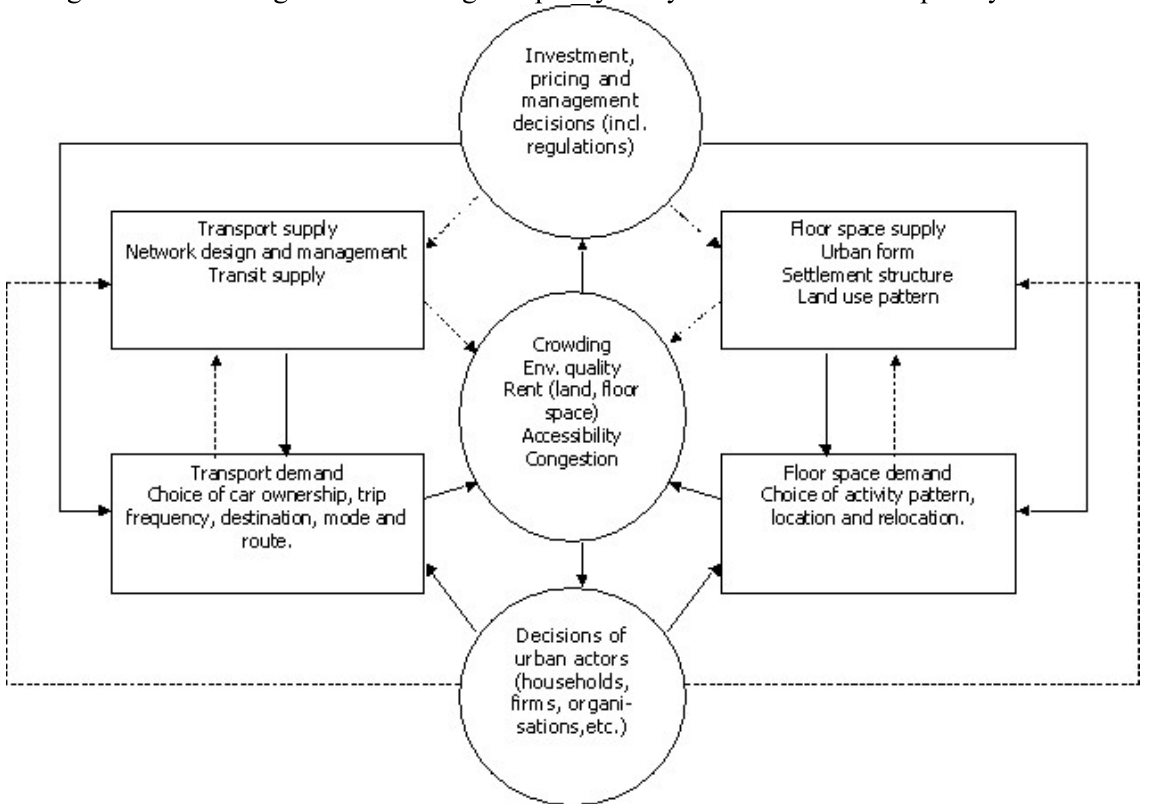
Figure 1. Linkages between the transportation market and the land-use market (dotted arrow: medium to long-term impacts; solid arrow: short to medium-term